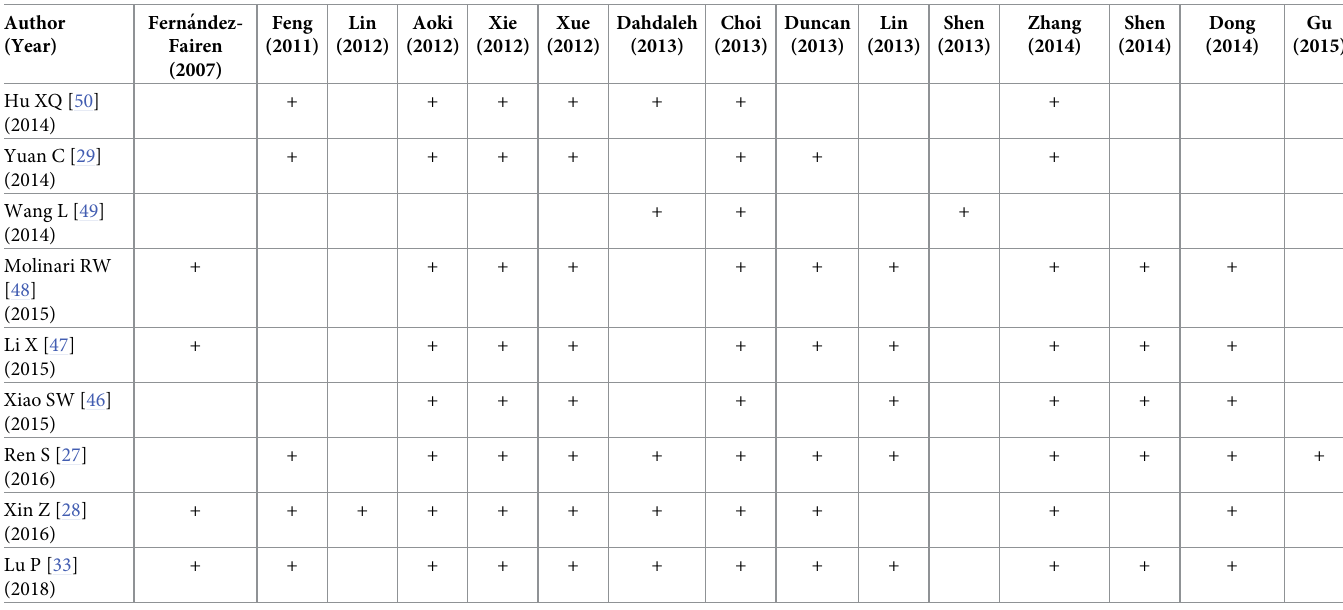
Table 2. Primary trials included in each